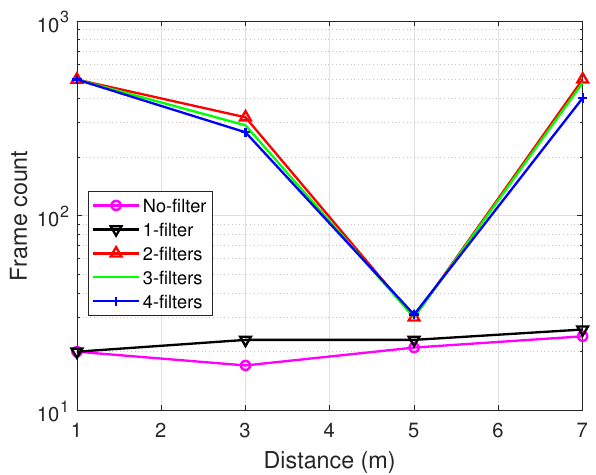
Figure 10. Number of frames extracted from received